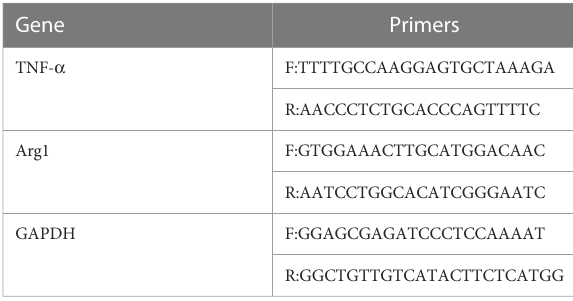
TABLE 2 Real-time qPCR ampli fi cation